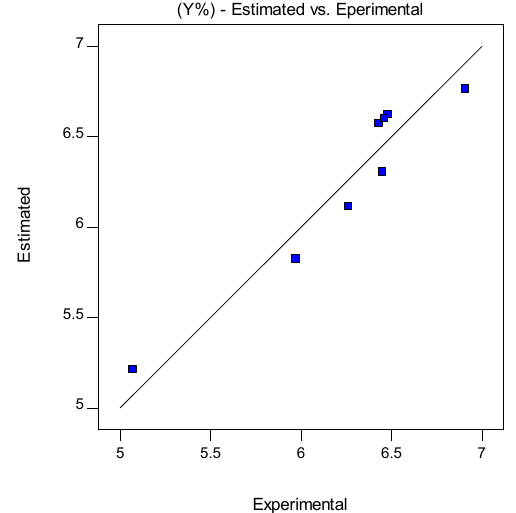
Figure 1. Estimated (represented by the straight line), and experimental values for the rice bran oil yield (%) recovered by scCO 2 extraction, and at the FFD design tests conditions shown in Table 1. Among the three factors with values greater than p > 0.050 analyzed, the scCO 2 flow rate was identified as the variable without significance to the model.